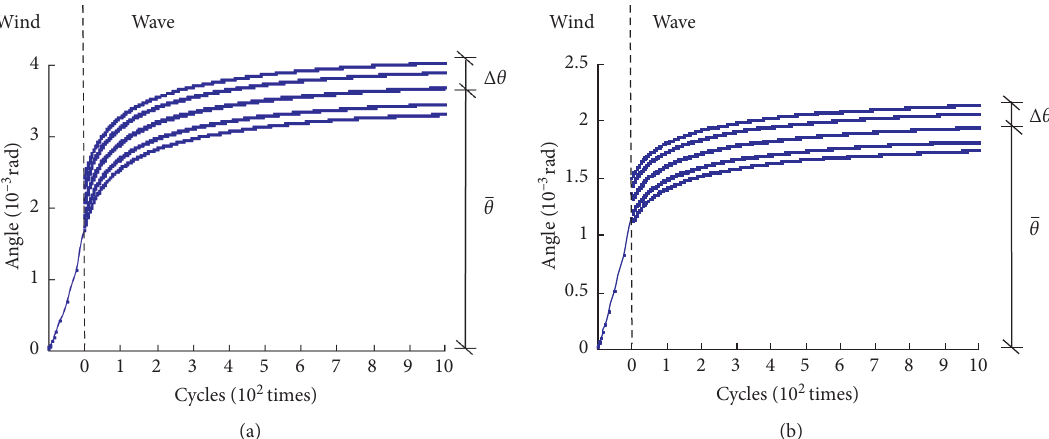
Figure 7: Relation of rotation and cyclic numbers of bucket foundation of aspect ratio L / D � 0.2. (a) Imperfect interface. (b) Full bonding.